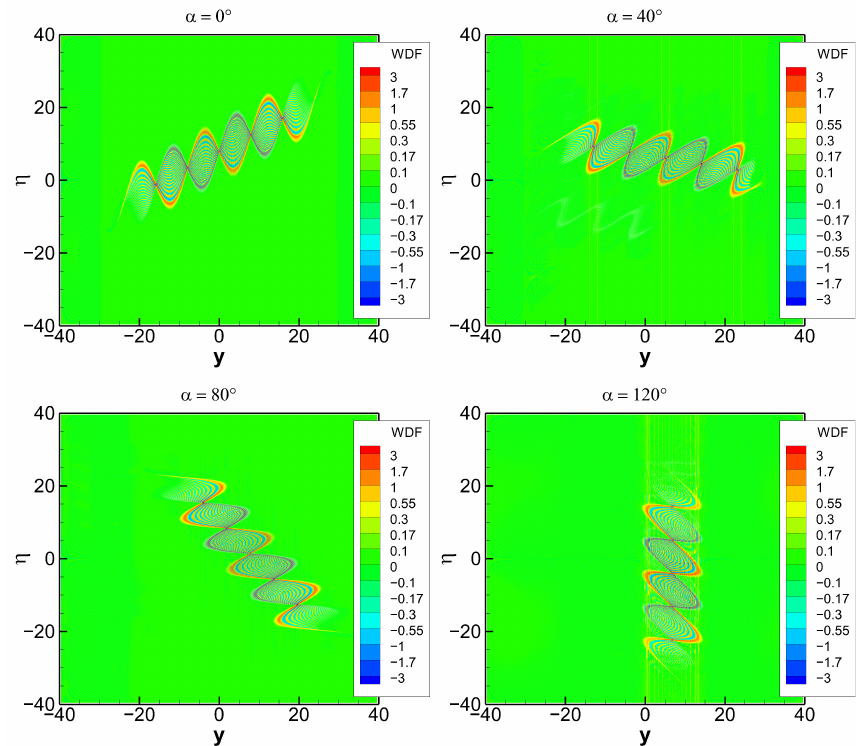
Figure 8. WDF ρ W α of function ˜ ψ α ( y ) in rotated coordinates ( y , η ) . The rotation angle α takes the values of 0 ◦ , 40 ◦ , 80 ◦ , and 120 ◦